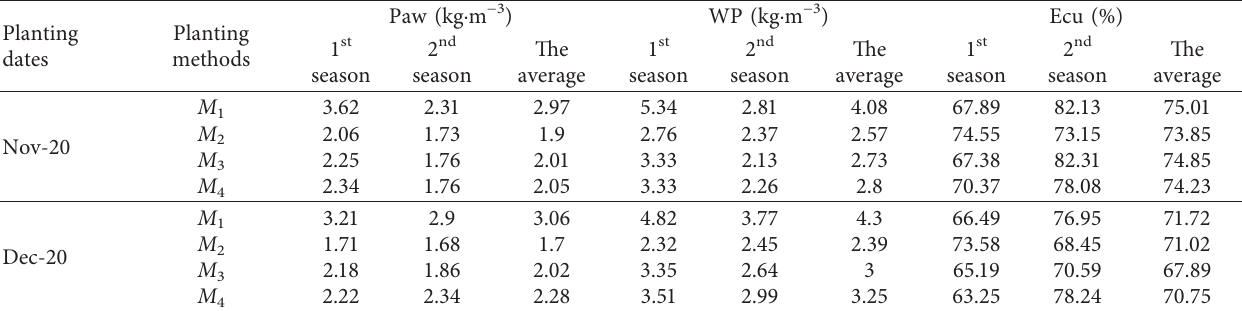
Table 6: Effect of planting dates and planting methods treatments on the productivity of irrigation water (Paw, kg · m 3 ), water productivity (WP, kg · m 3 ), and efficiency of water consumptive use (Ecu, %) in the two growing seasons. Planting Planting dates methods